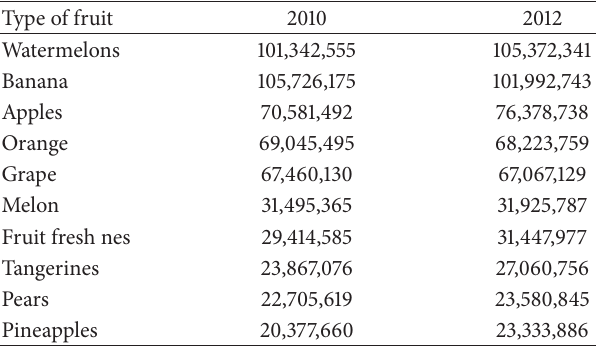
Table 4: World production of fruit crops in the years 2010 and 2012 in